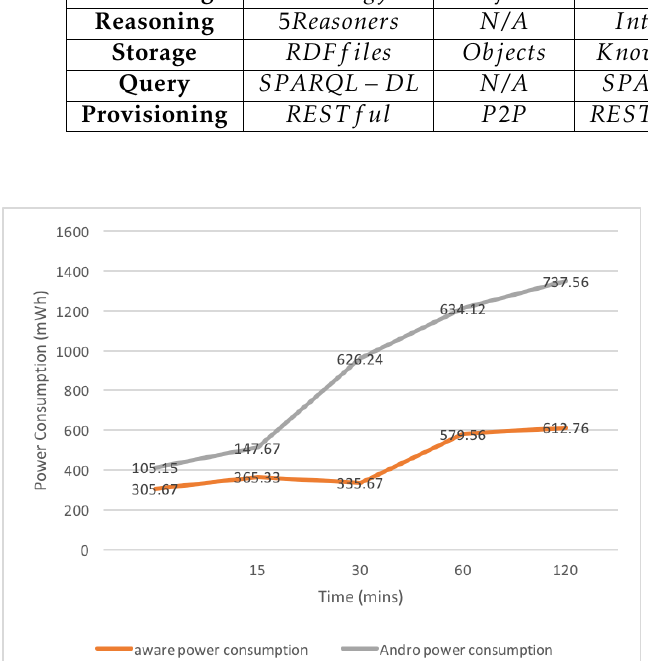
Figure 8. AndroCon Vs AWARE powerConsumption